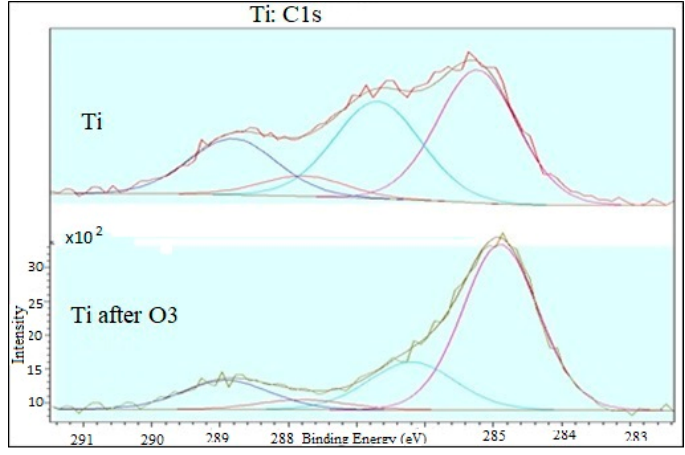
Figure 11. Matching XPS spectrum to C1s band.